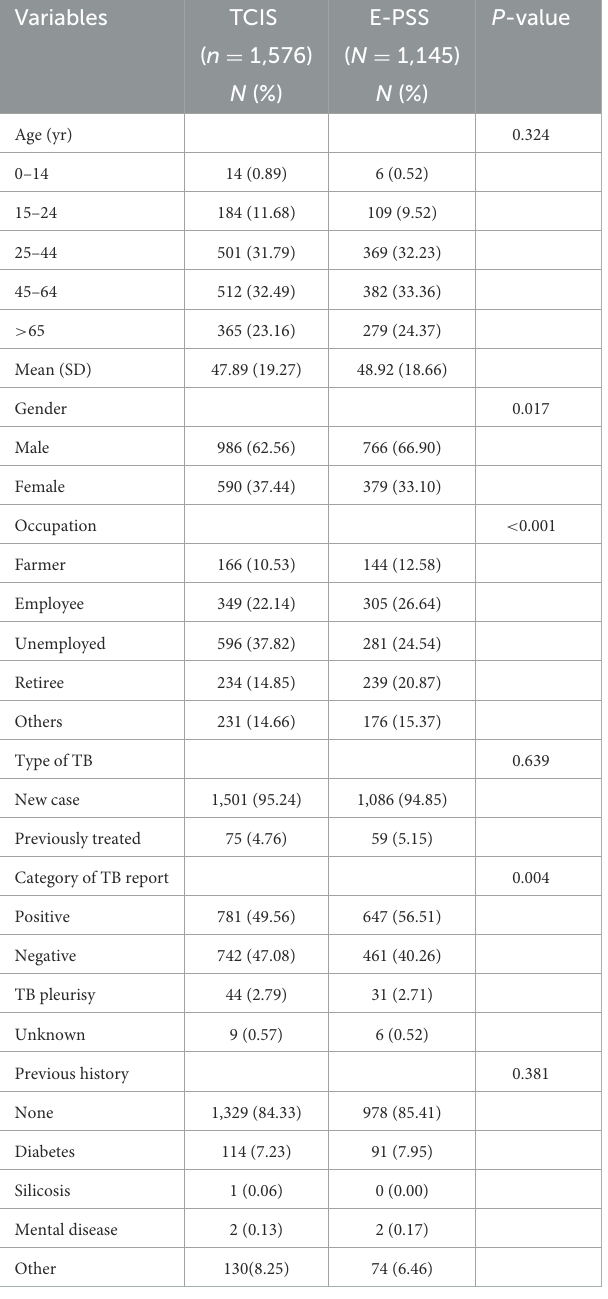
TABLE 1 Patient demographics and clinical characteristics recording in TCIS and e-PSS during 2020–2021 in Wuhan.